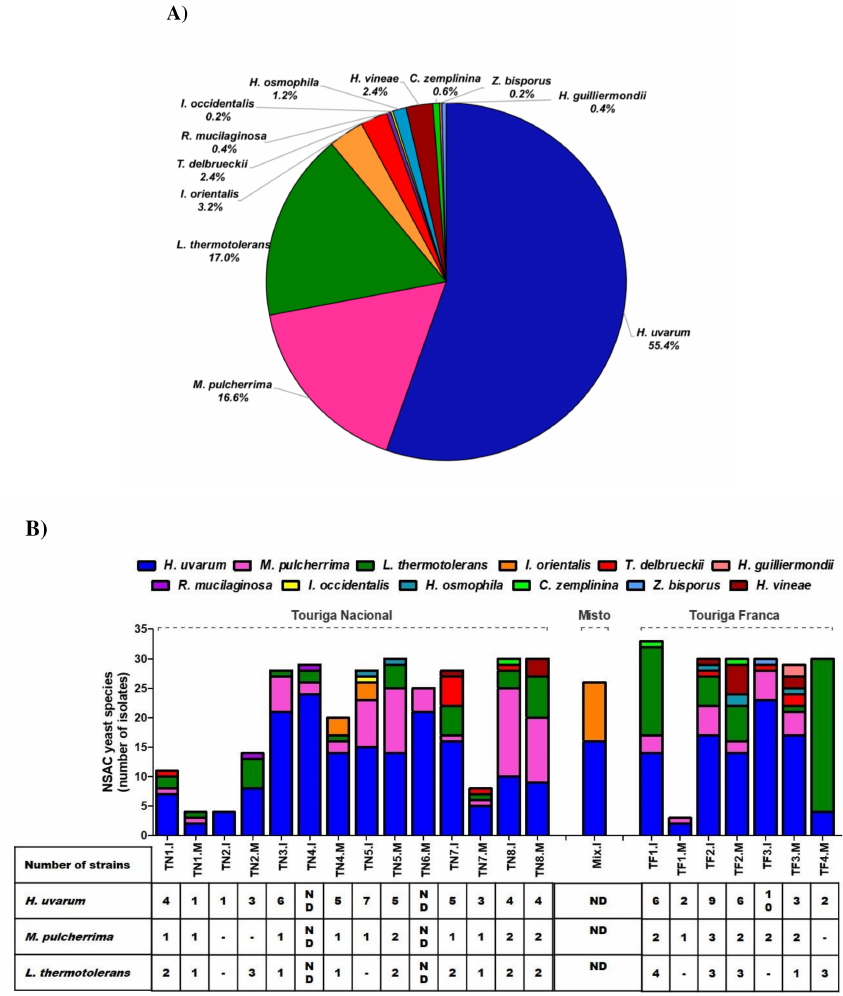
Figure 1. Distribution of non- Saccharomyces species isolated from Port wine must samples. ( A ) The total distribution of non- Saccharomyces species isolated from Port wine must samples. Port wine must samples were plated in YEPD and lysine medium, and the identification of the yeast isolates was performed by PCR analysis of the 5.8-ITS rRNA region. ( B ) Strain distribution in Port wine must samples collected at the beginning of AF (“I” samples) compared to a later stage, prior to fortification (“M” samples). The number of strain clusters for H. uvarum , L. thermotolerans , and M. pulcherrima species in each must sample is represented in the table. Strains were analyzed by RAPD-PCR and grouped in the same cluster when similarity values were ≥ 80% (Dice similarity coe ffi cient with a tolerance of 10, and the UPGMA